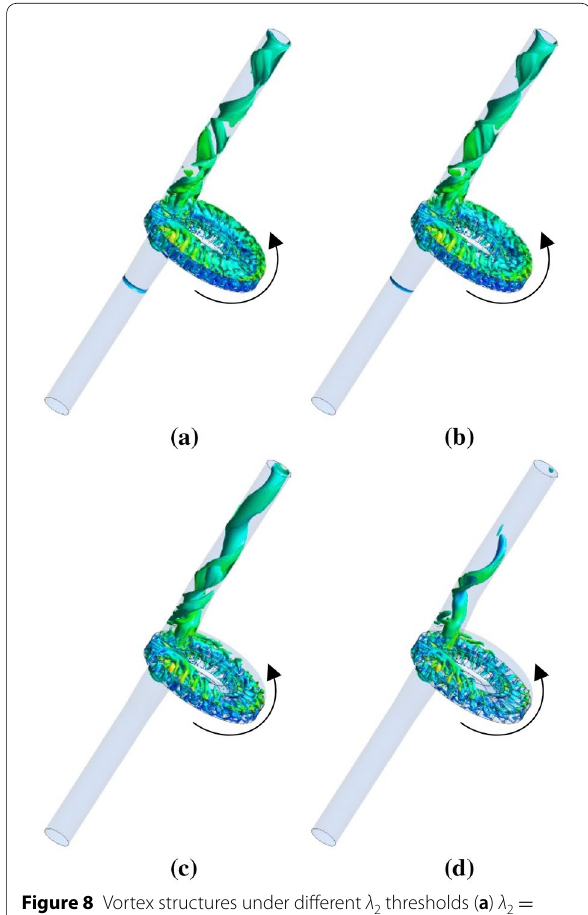
Figure 8 Vortex structures under different λ 2 thresholds ( a ) λ 2 =